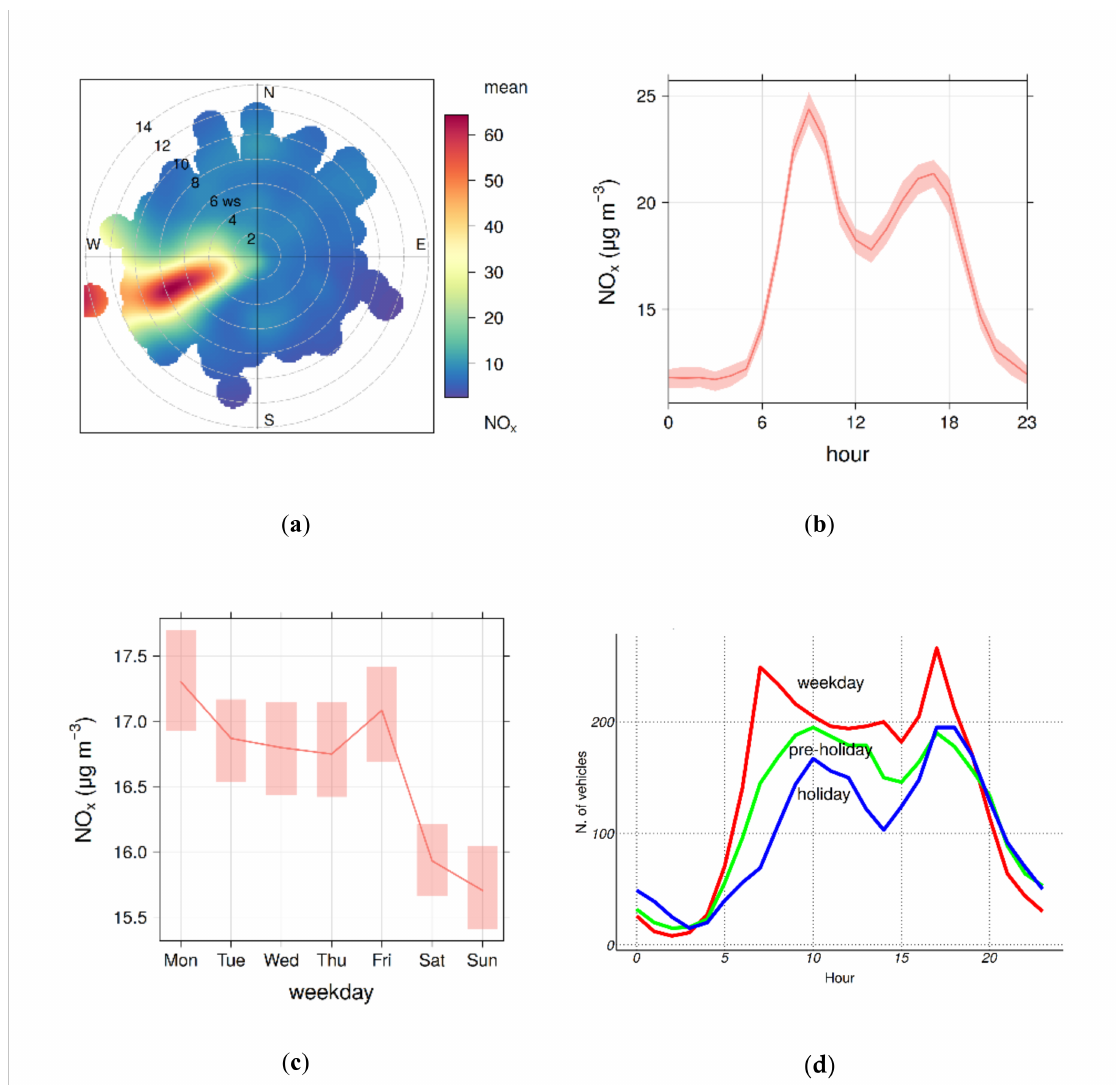
Figure 4. Polar plot ( a ) , daily ( b ) and weekly ( c ) profiles of hourly NO X concentrations over the 2013– 2019 period. Also shown on the plots ( b , c ) is the 95% confidence interval in the mean. ( d ) Average hourly trend of traffic flows of the national road SS598 in